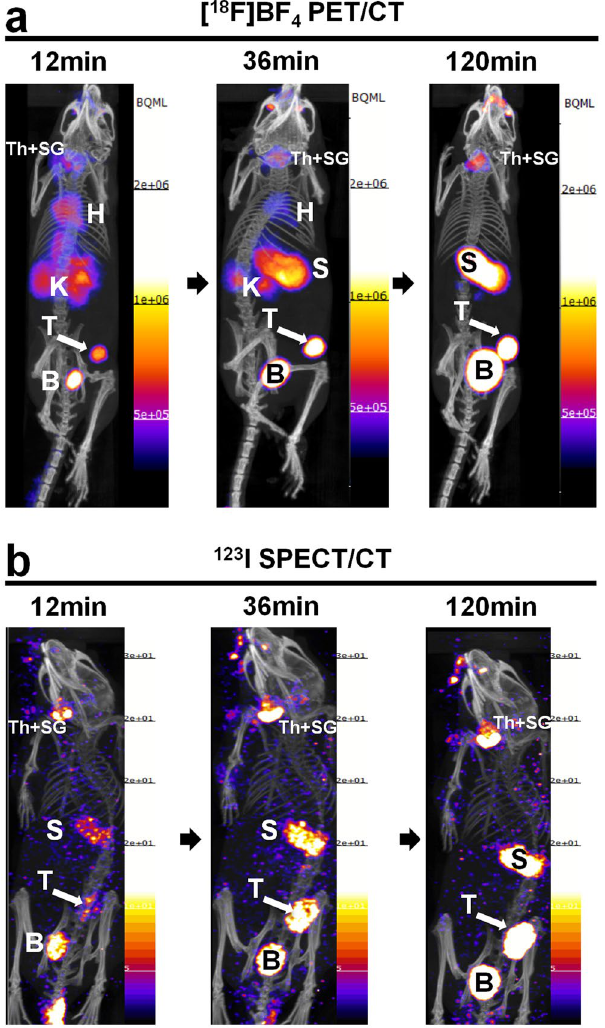
Figure 3. Comparative in vivo NIS imaging indicates differences between the PET tracer [ 18 F]BF 4 − and the SPECT tracer [ 123 I]iodide. Tumors were established as in Fig. 2 but grown to sizes of ~350 mm 3 (see Supplementary Fig. S2B) before being imaged by either [ 18 F]BF 4 − -PET ( a ) or [ 123 I]iodide-SPECT ( b ). Dynamic PET data were binned into time intervals comparable to sequential SPECT images (see Materials and Methods). Al images are maximum intensity projections overlaid on CT. Abbreviations are: bladder (B), heart (H), kidney (K), stomach (S), thyroid and salivary glands (Th + SG), and primary tumor (T). Representative images of cohorts of N = 3 are